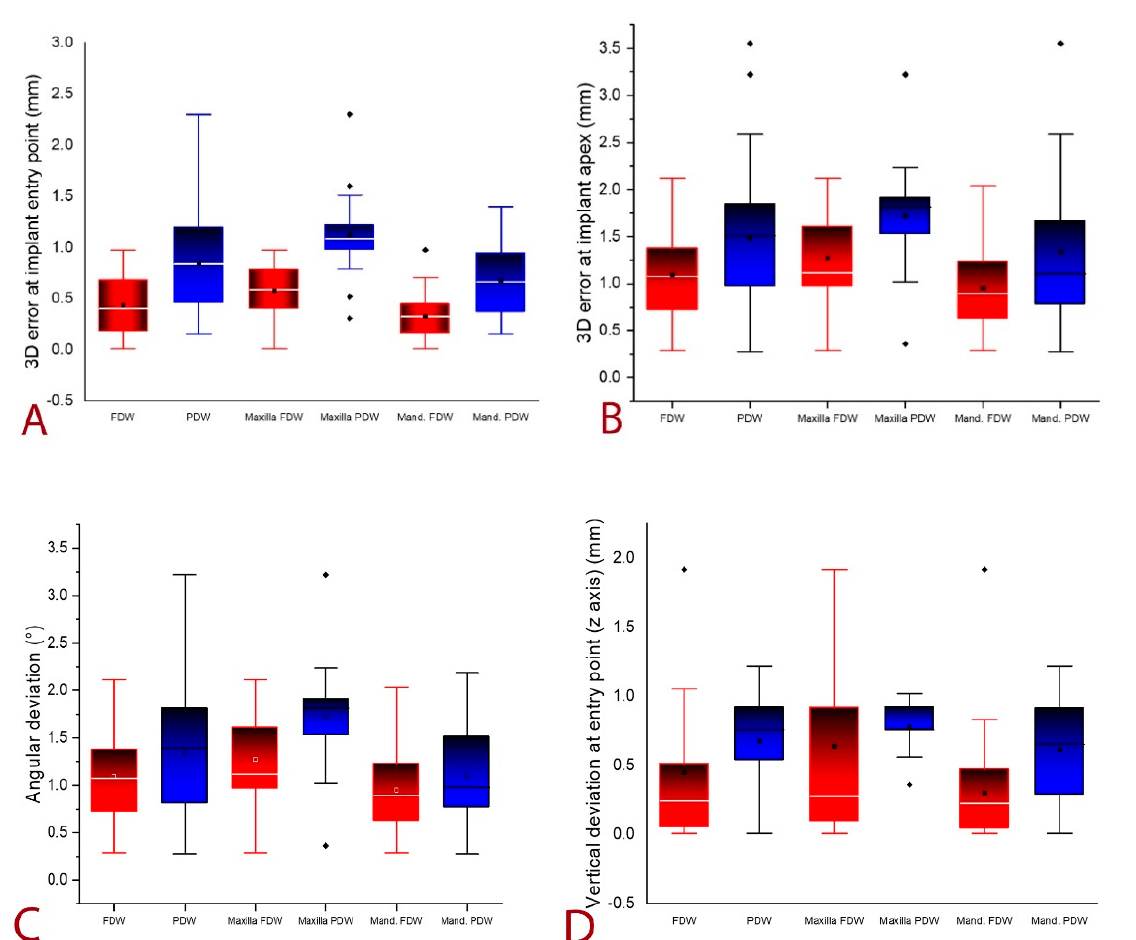
ᵻ range within IQR,—median line, □ mean,